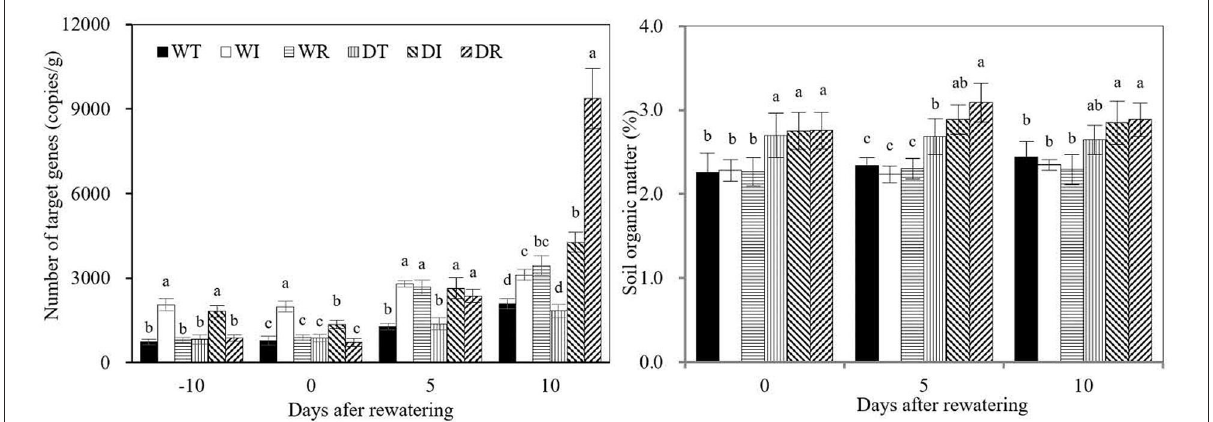
FIGURE8 S2_8_1 number in rhizosphere soil and soil organic matter in the study. WT, WI, WR, DT, DI, and DR indicate treatments of wetness, wetness with AOB strain inoculation during wet period, wetness with AOB strain inoculation during rewatering period, post-drought rewatering, post-drought rewatering with AOB strain inoculation during wet period, post-drought rewatering with AOB strain inoculation during rewatering period, respectively. In “ − 10” means the 10th day before the beginning of rewatering, namely the end of the wet period. In “0”, “5”, and “10” respectively stand for the beginning, 5th day, 10th day of the rewatering period of 10 days. The values are the mean ± standard error ( n = 3). The different letters in each row indicate significant differences ( P <